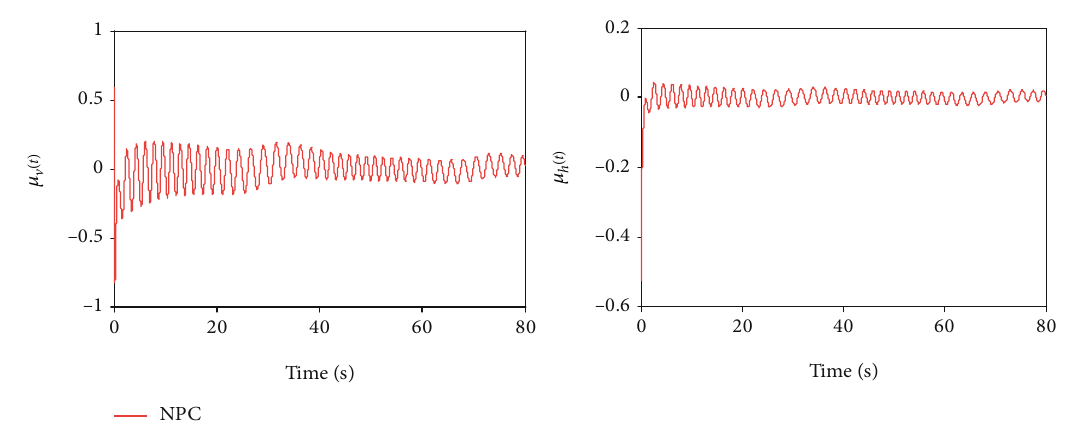
ð t Þ of the case. h